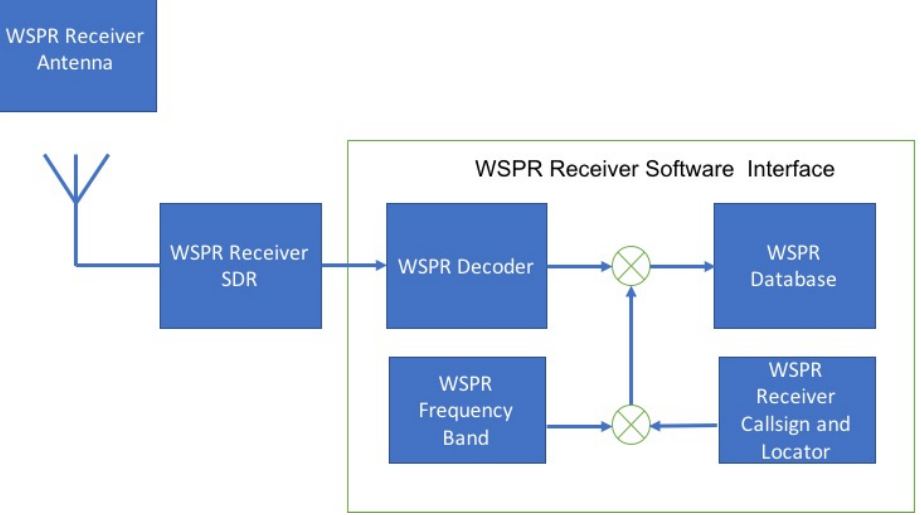
Figure 3. WSPR receiver block diagram example with SDR receiver.